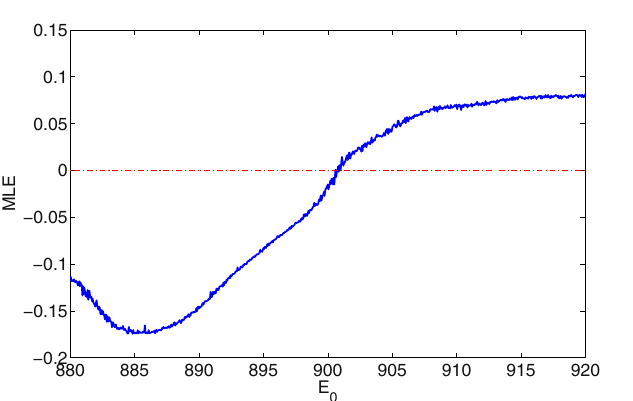
Figure 3. ( a , d and g ) are time series of q when E 0 = 10, E 0 = 200 and E 0 = 980 with fixed E 1 = 5000; ( b ),( e ) and ( h ) are phase diagram between q and p of the mechanical state when E 0 = 10, E 0 = 200 and E 0 = 980 with fixed E 1 = 5000; ( c ),( f ) and ( i ) plot the real part versus imaginary part of optical state a when E 0 = 10, E 0 = 200 and E 0 = 980 with fixed E 1 = 5000.